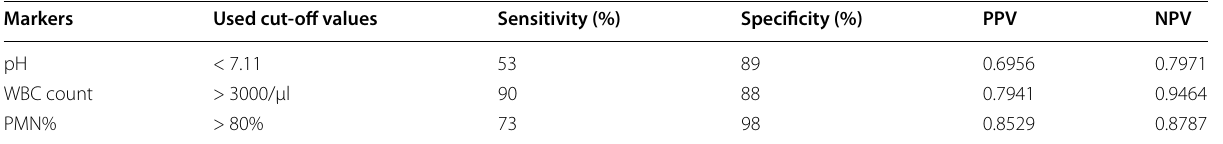
Table 1 Results for synovial pH value, synovial white blood cell (WBC) count and percentage of synovial neutrophils (PMN%) in diagnosing prosthetic joint infection (PJI)